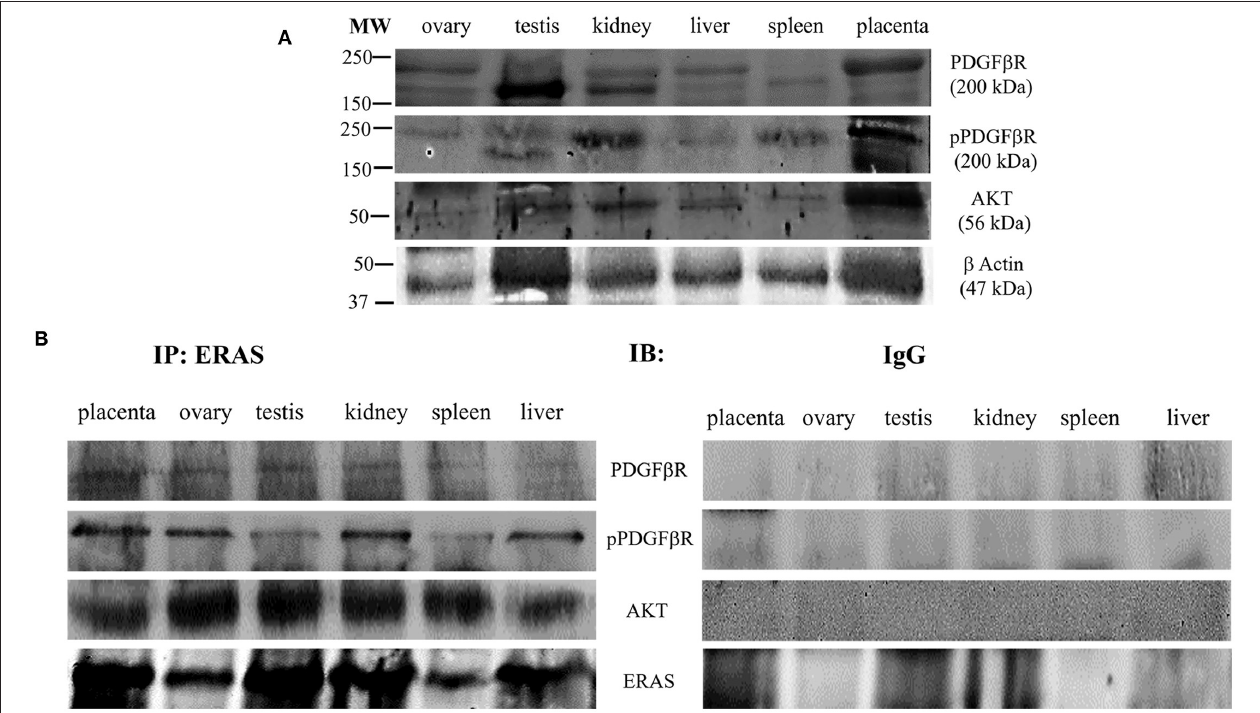
FIGURE 5 | (A) Representative WB analysis and (B) ERAS immunoprecipitation (IP) of pPDGF β R, total PDGF β R and AKT in equine tissues from several animals. WB analysis performed on IP revealed that ERAS interacted with pPDGF β , PDGFR β and AKT.